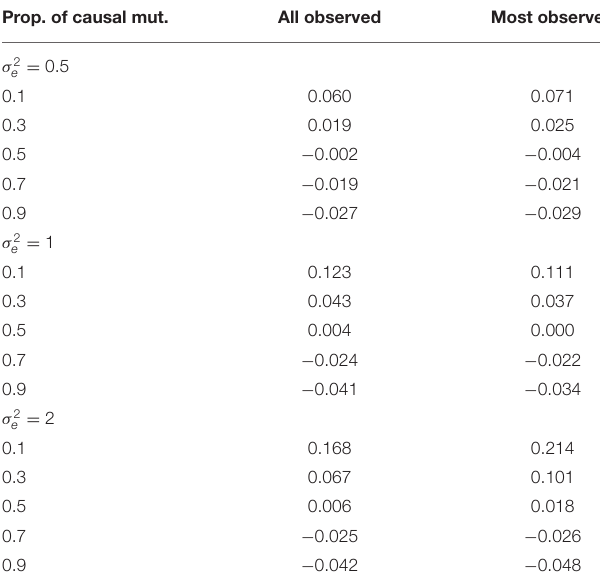
TABLE 2 | RCRPS between the HN model and the mutation model for mutation effects by different values of residual variance σ 2 e , proportion of causal mutations and for the two scenarios where either all or most haplotypes have direct links to observed phenotypes. Prop. of causal mut.